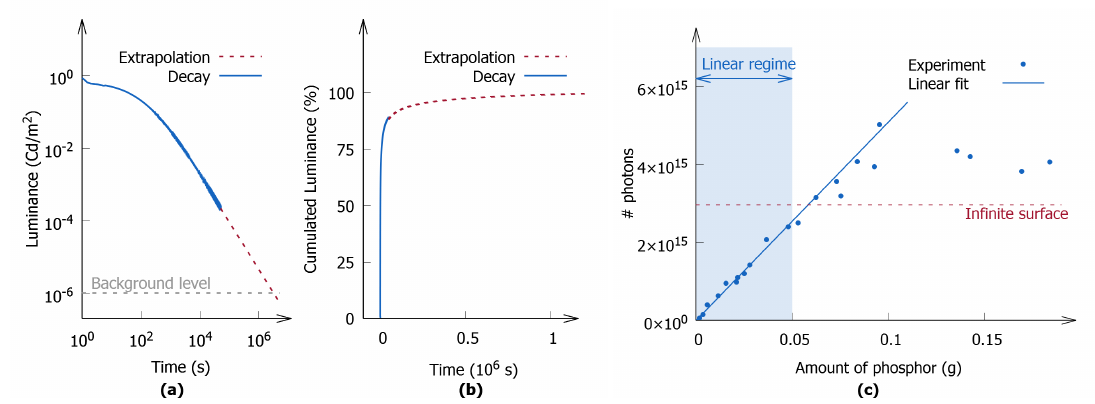
Figure 3. ( a ) An afterglow curve for a polymer layer containing 0.0032 g of SrAl 2 O 4 :Eu,Dy. The extrapolation method and the instrumental background level are also indicated; ( b ) Cumulative decay curve indicating the fractions of the total luminance that are measured or deduced from extrapolation; ( c ) The number of photons that were released from SrAl 2 O 4 :Eu,Dy during the afterglow after 15 min of excitation with a 450 nm LED ( E e = 0.43 mW/cm 2 ). The region where the number of photons was linearly related to the amount of phosphor incorporated in the layers is also indicated. The level indicated as “infinite surface” corresponds to the number of photons calculated from a luminance decay curve that was measured on an infinitely thick